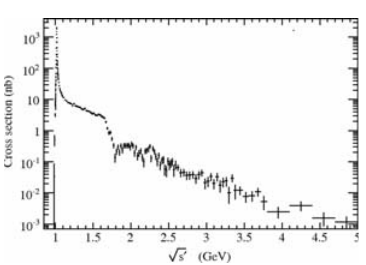
Figure 4. The e + e − → K + K − hadronic bare cross section (including FSR) at B A B AR . The J /ψ and ψ (2 S ) resonances to K + K − have been subtracted. The systematic uncertainty at the φ peak is 0.8%.